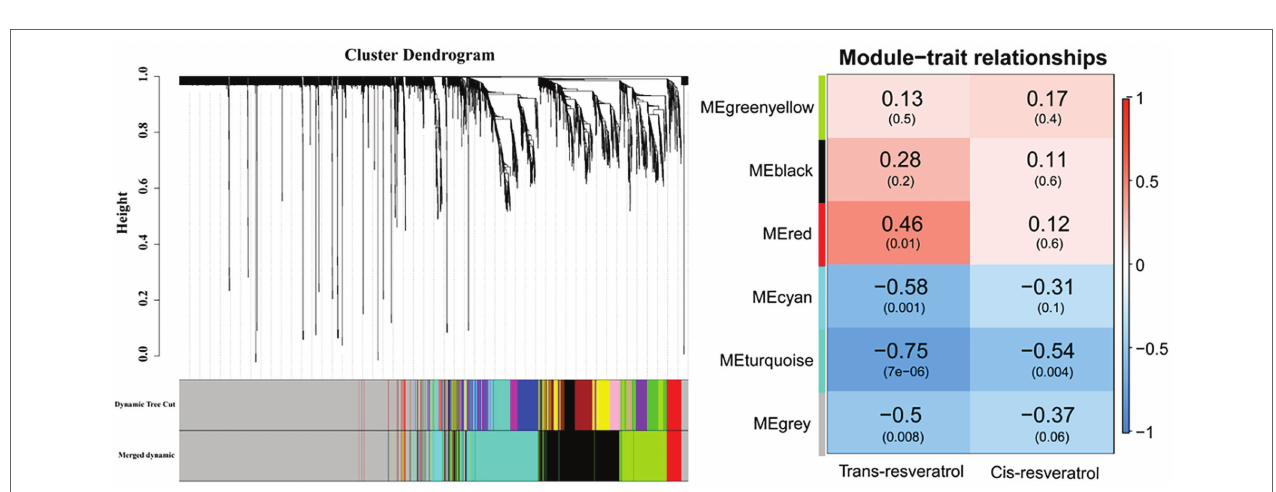
FIGURE 5 | Biosynthetic pathway of resveratrol in grape berries. Boxes from left to right that follow the berry development were obtained by using the MultiExperiment Viewer software. The data set comprised of data regarding the changes in the relative expression of the ‘Nantaihutezao’ in relation to the ‘Summer Black’ at the same stage, which were expressed as log 2 fold change.